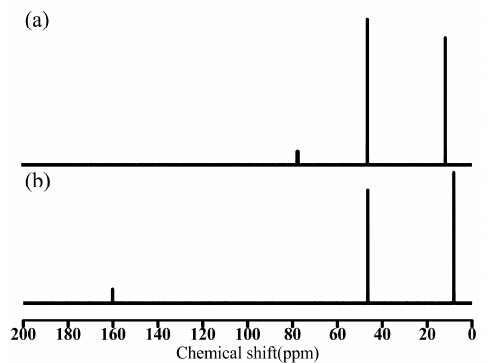
Figure 4. The 13 C nuclear magnetic resonance (NMR) spectra of ( a ) Et 3 N in CDCl 3 , ( b ) SHT in D 2 O.